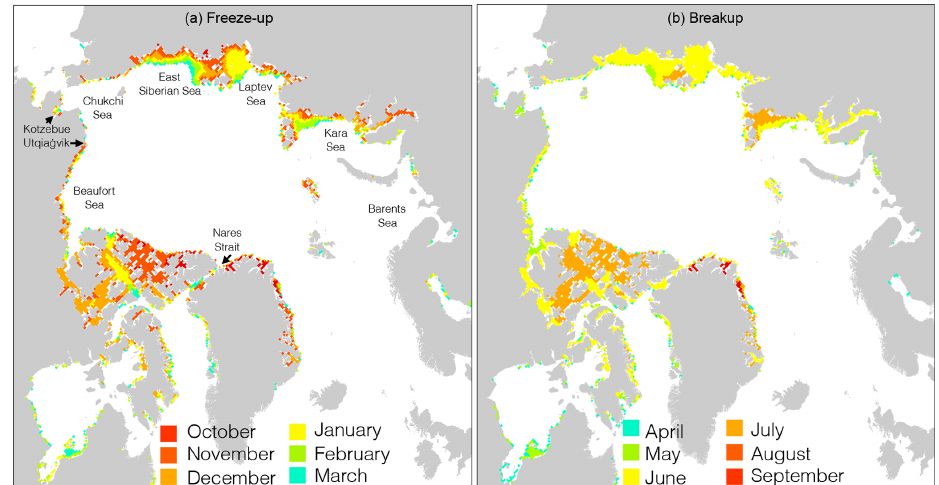
Figure 1. (a) October–March (freeze-up) and (b) April–September (breakup) monthly mean landfast sea ice extent (1976–2007), derived from sea ice charts based on optical instruments and SAR. The data for this figure were obtained from the National Snow and Ice Data Center (Yu et al.,